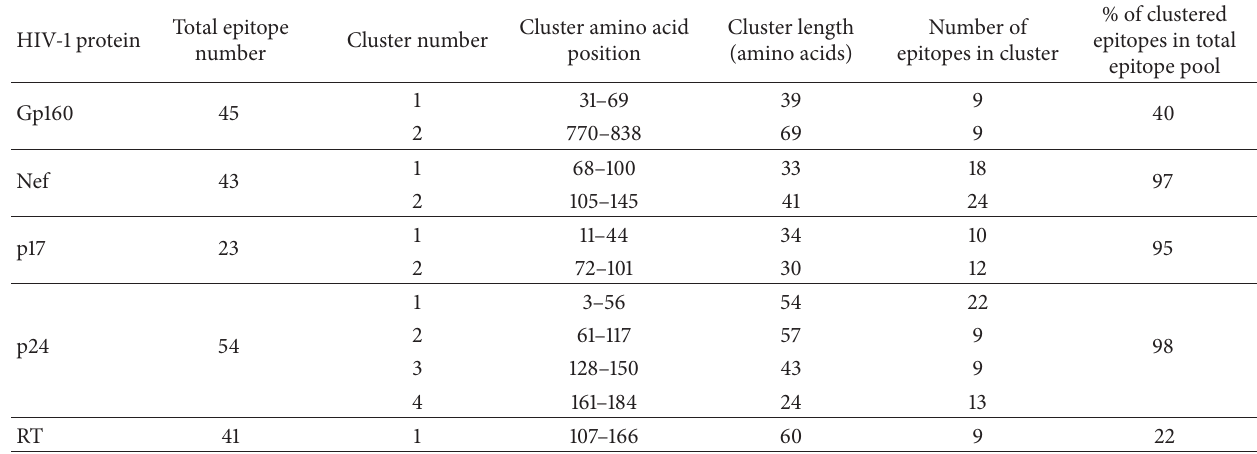
Table 3: Analysis of the identified epitope clusters in HIV-1